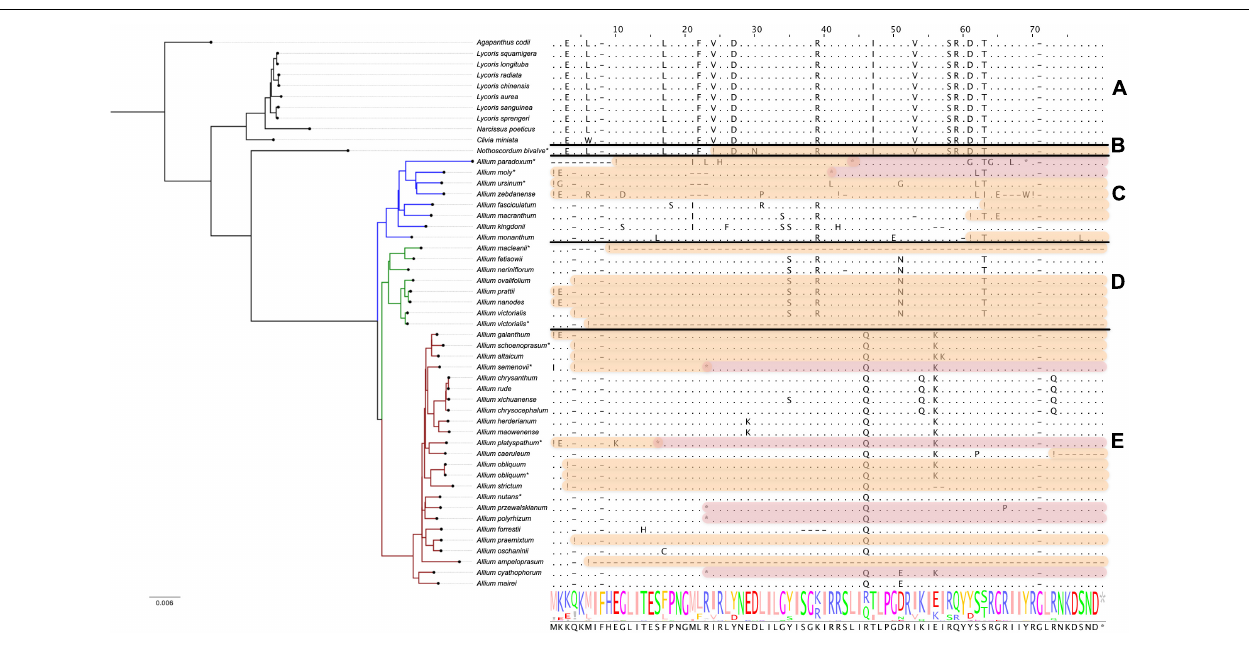
FIGURE 4 | Protein sequence alignment of the translation initiation factor IF-1 encoded by infA genes. Àll species are sorted by phylogenetic tree: the first evolutionary line of Allium is blue, the second is green, the third is red and the remaining species are black. Species sequenced by our group are marked with *. (A) Shows Agapanthoideae and Amaryllidoideae subfamily species; (B) shows Nothoscordum bivalve as an outgroup for Allium genus; (C) shows the first evolutionary line Allium species; (D) —the second and (E) —the third. Non-conserved AA positions are highlighted as letters and conserved as dots. The whole AA sequence is shown as a normalized alignment logo below. Possible frameshifts are shown as ! and stop codons as *. Damaged sequences are highlighted in peach color in case of frameshift and in purple in case of stop codon. Colored sequences may be assumed to be a pseudogene.